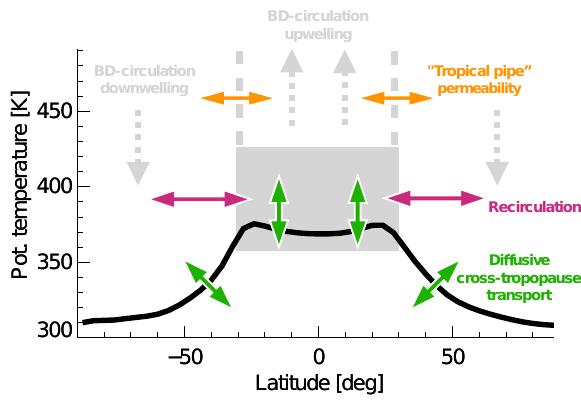
Figure 12. A schematic of considered processes critical for the distribution of water vapour in the LS region. Grey arrows rep- resent Brewer–Dobson upwelling throughout the tropical region and downwelling towards the poles, green arrows stand for cross- tropopause transport through the whole latitudinal range, the pink arrows represent the region of recirculation of air masses in TTL and the orange arrows show the regions of “tropical pipe” perme- ability. TTL is represented by the solid grey